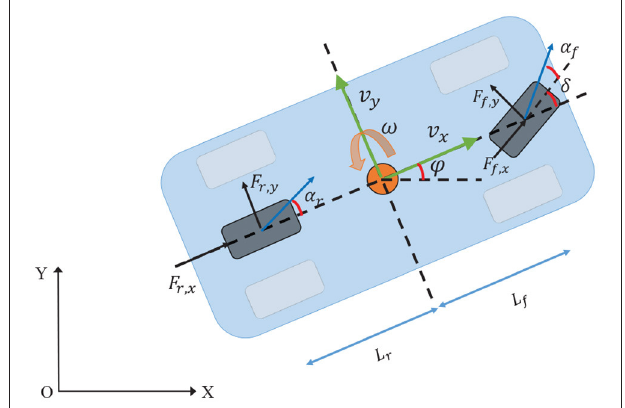
FIGURE 1 | A schematic drawing of the bicycle